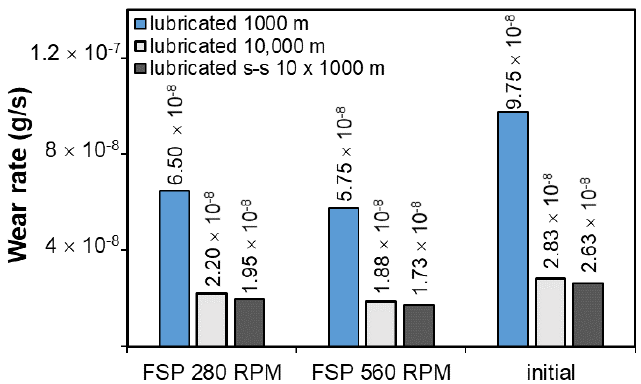
Figure 17. Wear rate of B89 alloy as a function of time and process conditions.